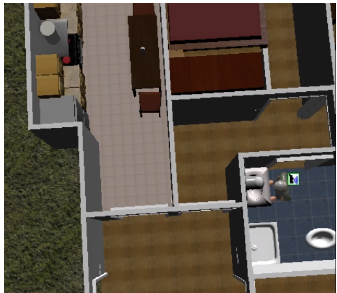
Figure 10. 3D simulation of the activities from Figure